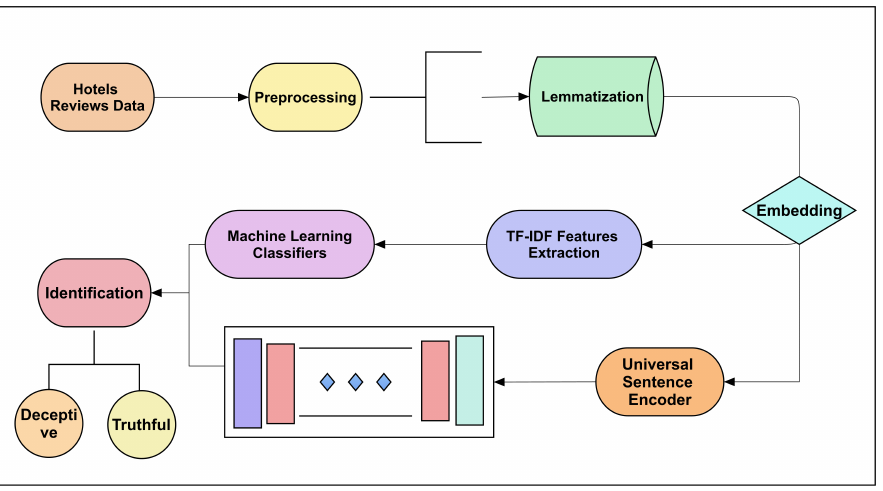
Figure 1. Flowchart containing primary steps applied in proposed